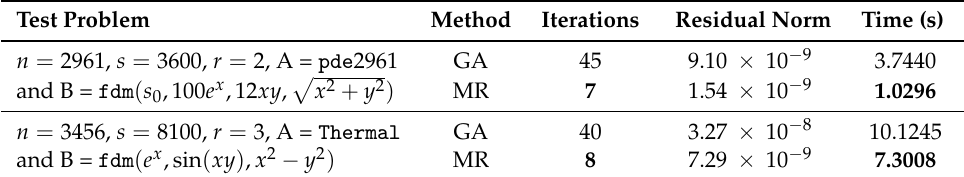
Table 2. Results for Example